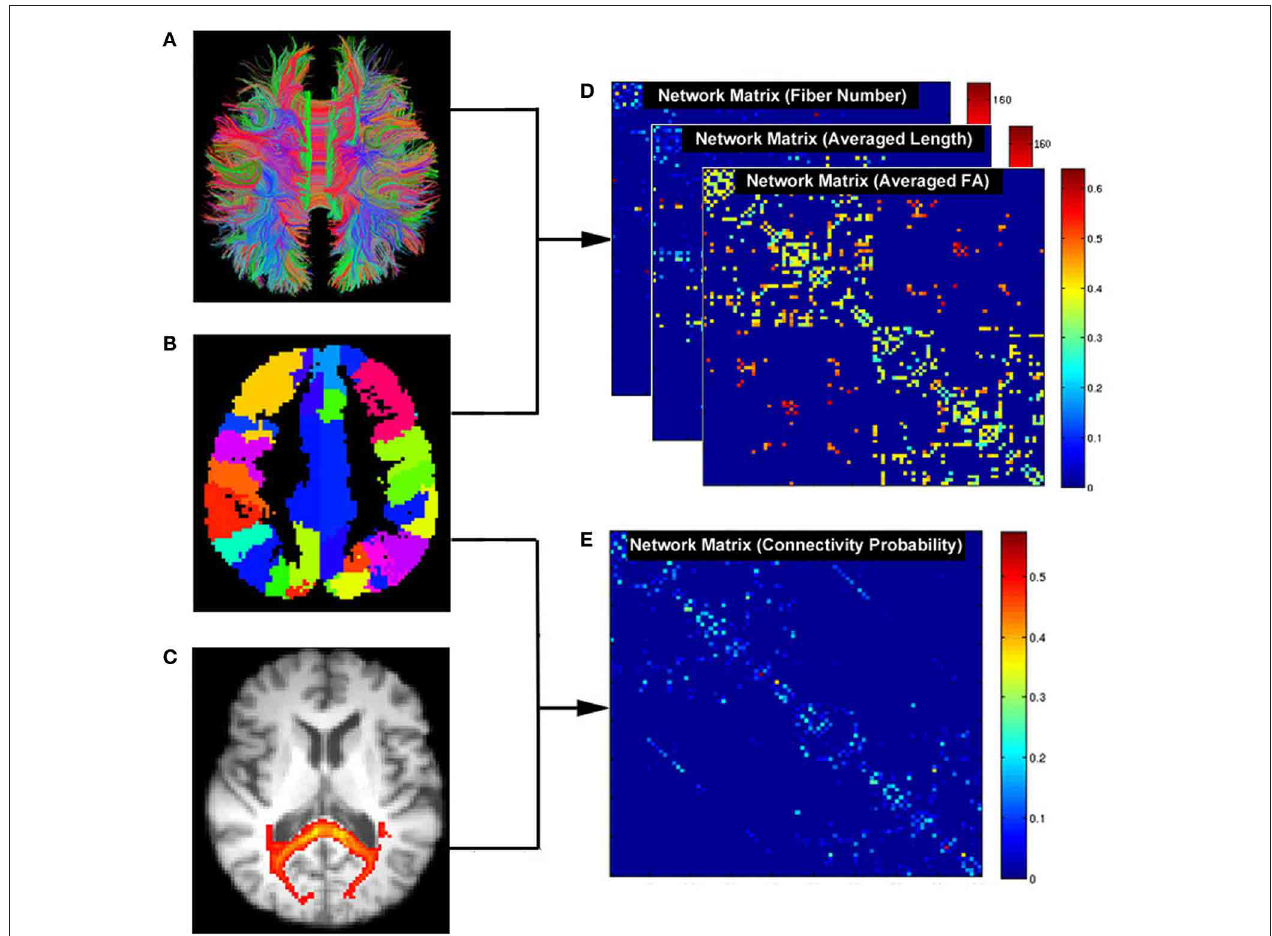
FIGURE 2 | Flowchart for constructing anatomical brain networks using diffusion tractography in PANDA. (A) White matter tracts reconstructed using deterministic tractography. (B) Parcellation of gray matter in diffusion space. Each color represents a node in a brain